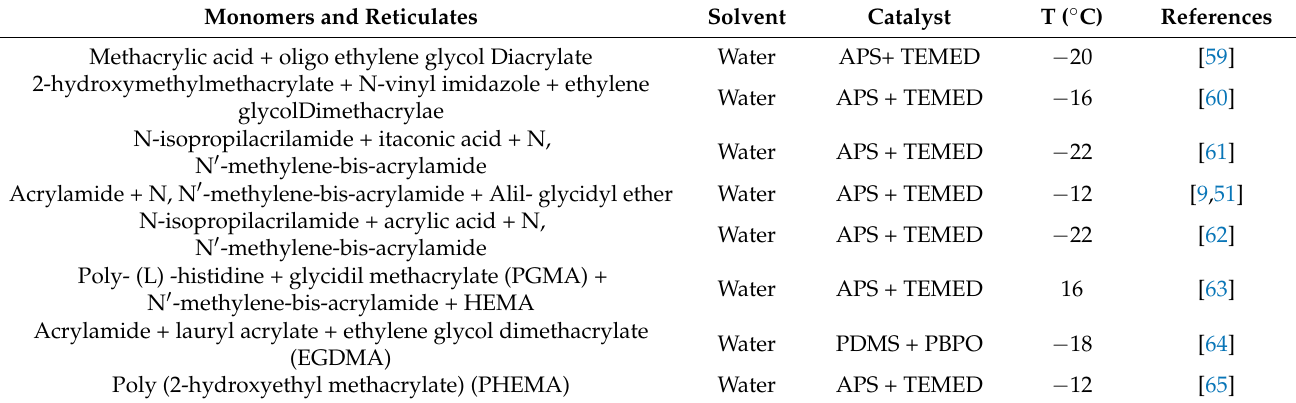
Table 4. Examples of systems for the preparation of polymeric